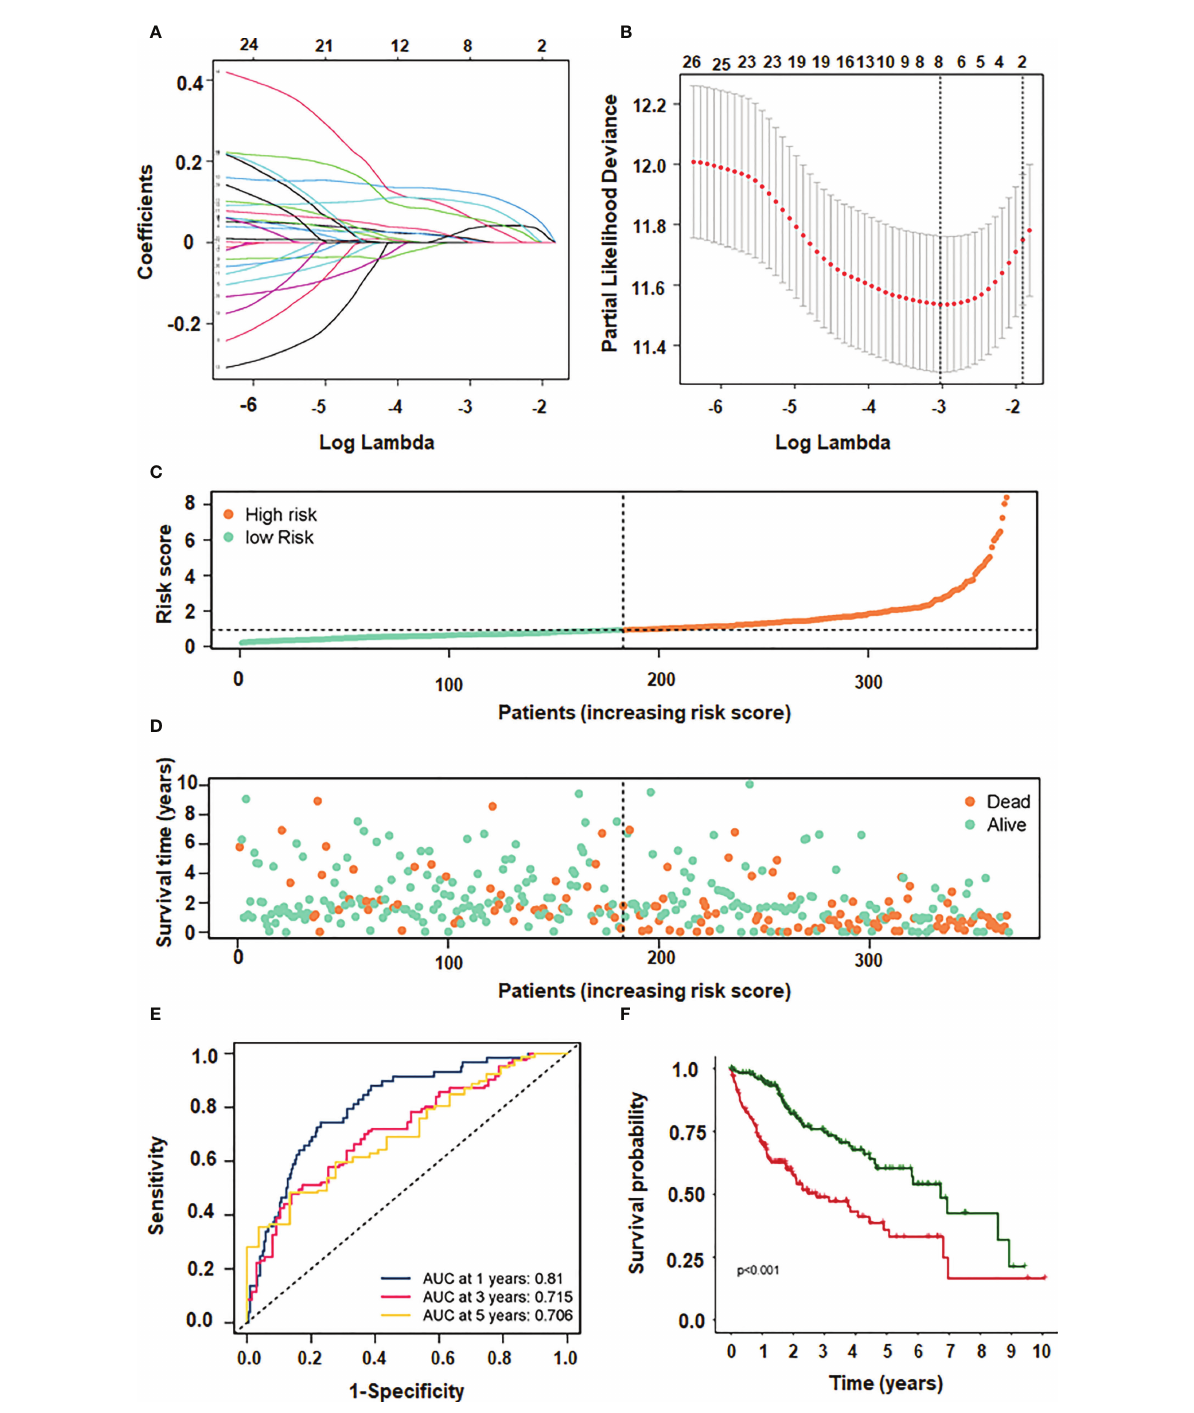
FIGURE 4 LASSOandmultivariateregressionmodelsscreening4genes. (A) differentcharacteristicsofgenesandtheircorrespondingcoef fi cients. (B) cross-validationto buildthemodel. (C) riskscorewithsurvivalstatuscases. (D) riskscorewithsurvivaltime. (E) ROCcurveplottedunderthepredictionmodel. (F) KMcurveofthis